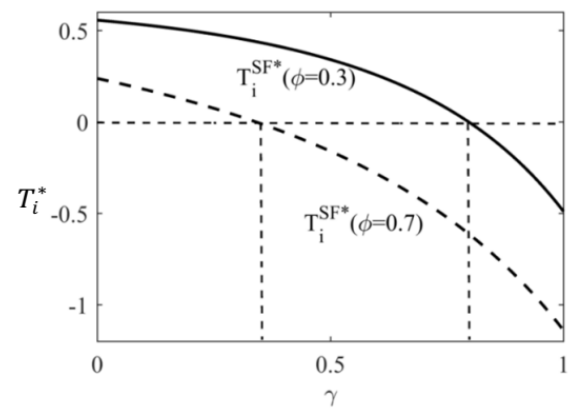
Figure 4. SF contract